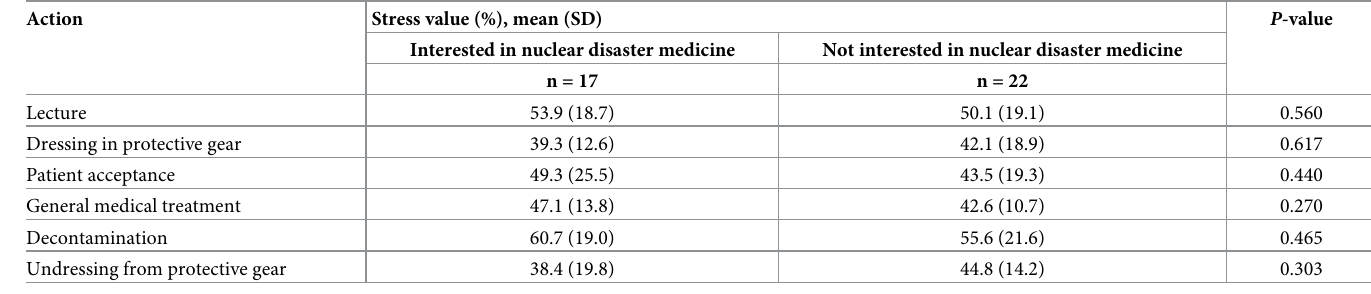
Table 3. Comparison between the groups with and without interest in nuclear disaster.